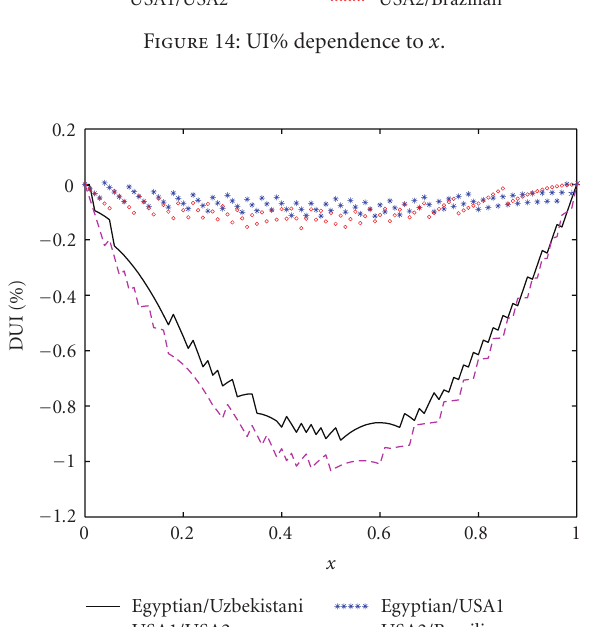
Figure 16: UR% dependence to x .